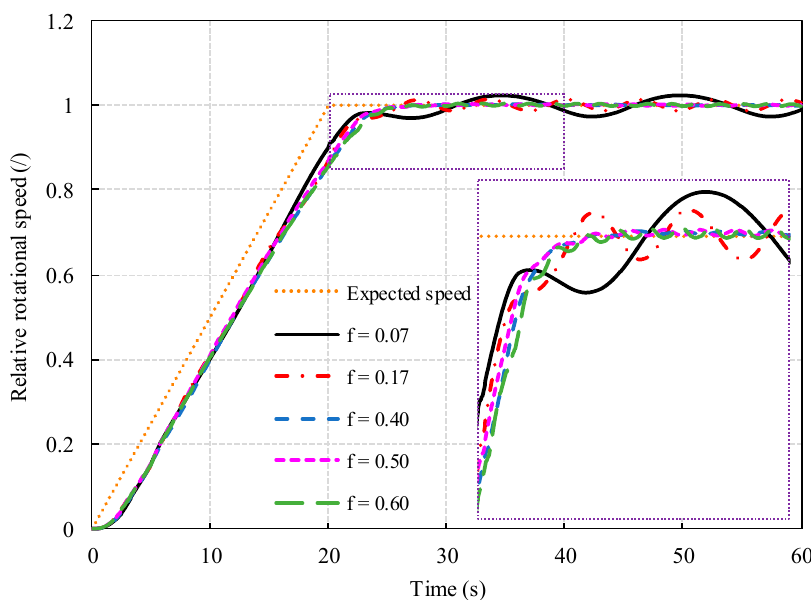
Figure 9. Comparison of closed-loop start-up speed characteristics of different tail water fluctuation frequencies under a fixed fluctuation amplitude.